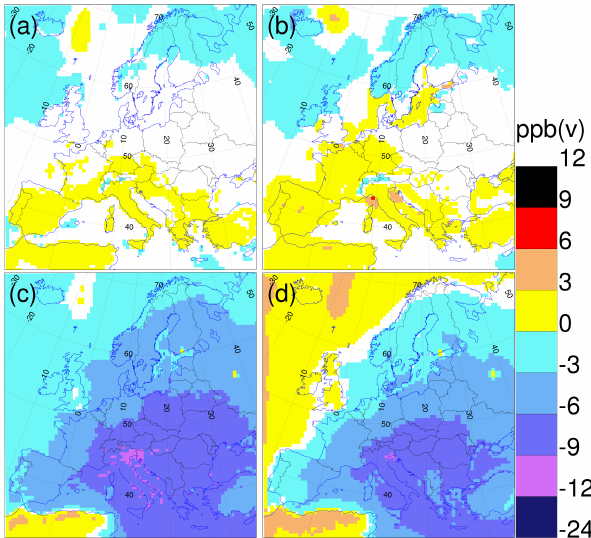
Fig. 3. Change in summer (April–September) mean surface O 3 con- centration from 1990–2009 to 2040–2059. (a) and (b) changes due to change in climate only; RCA3 downscaling of ECHAM5 and HadCM3, respectively. (c) ECHAM5 downscaling and change in European O 3 precursor emissions. (d) Increasing boundary case; the combined change due to change in climate, change in O 3 pre- cursor emissions and an increasing hemispheric background of O 3 of 0.1ppb(v)yr − 1 . Non-significant changes at 95% confidence level are masked white.